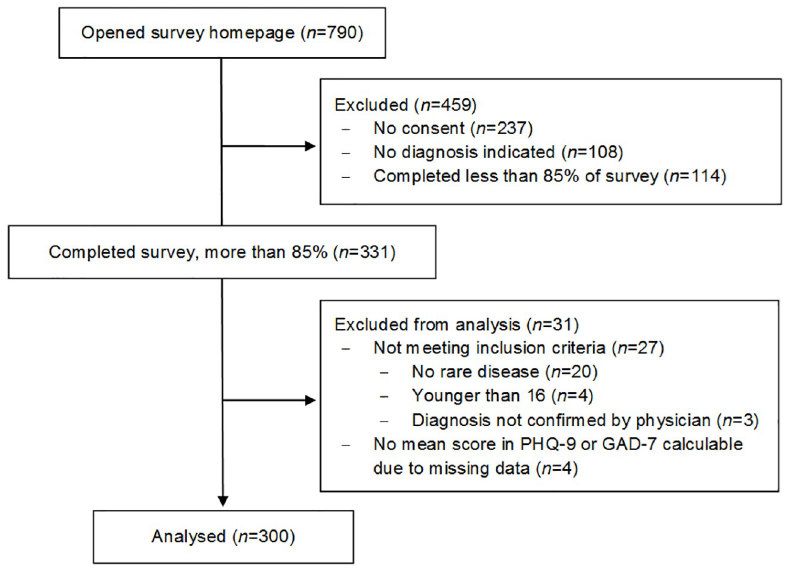
Fig 1. Flowchart.